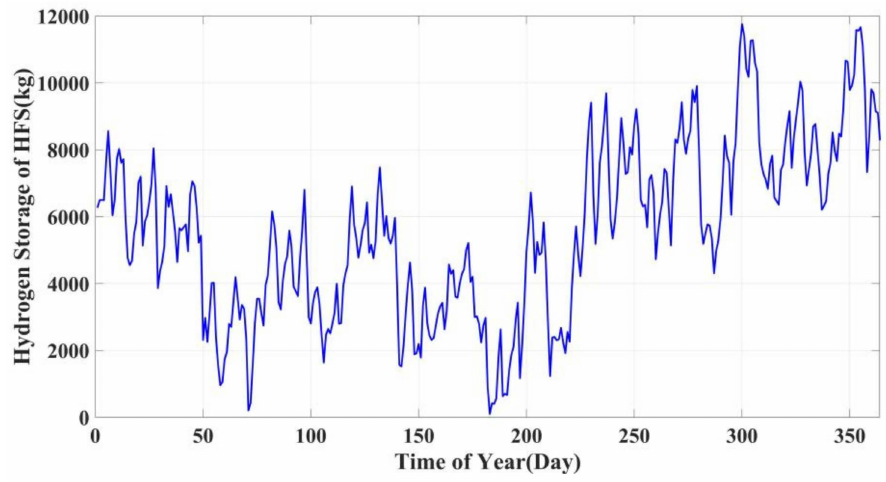
Figure 9. Yearly hydrogen storage of HRS with daily interval.